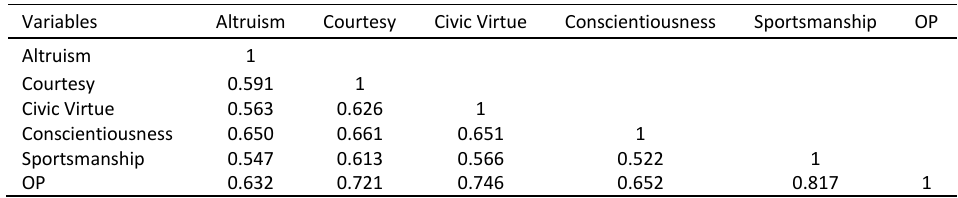
Table 3: The results of Spearman correlation Table3: the results of Spearman